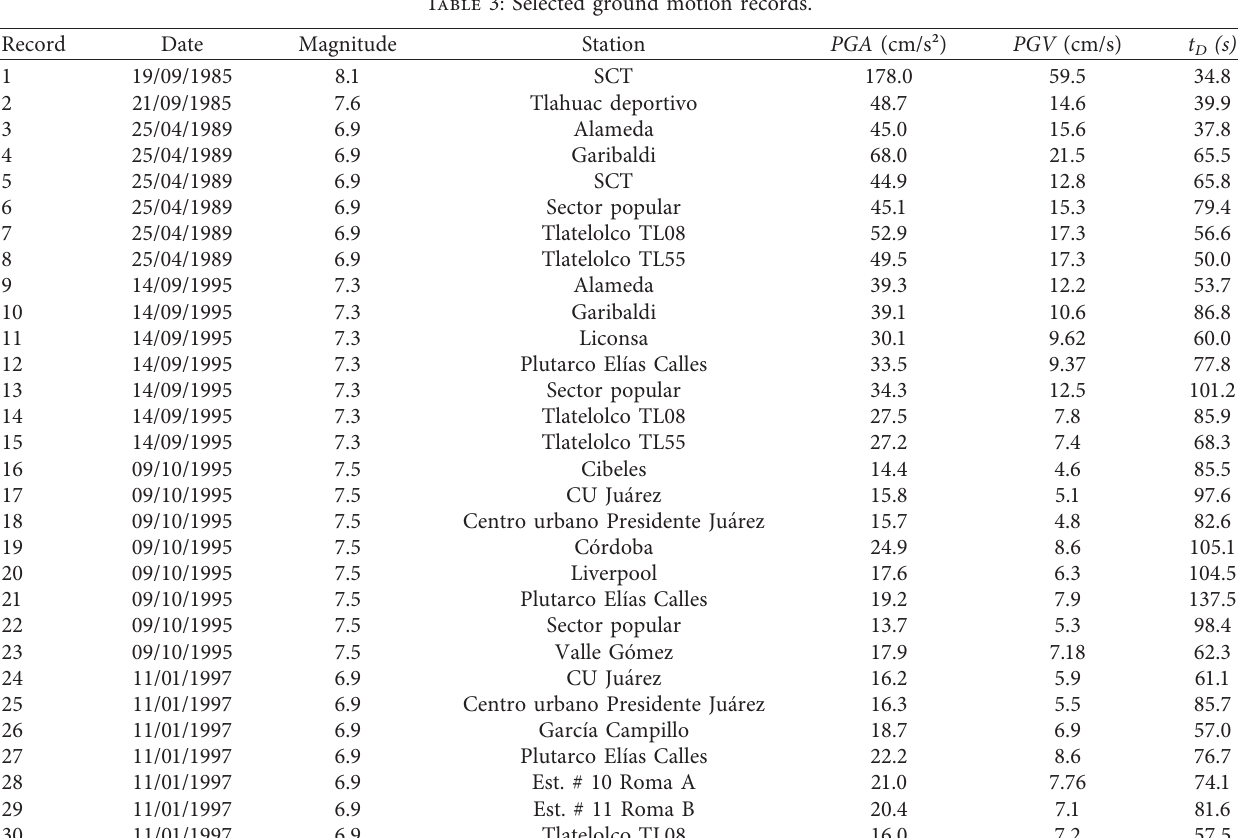
Table 3: Selected ground motion